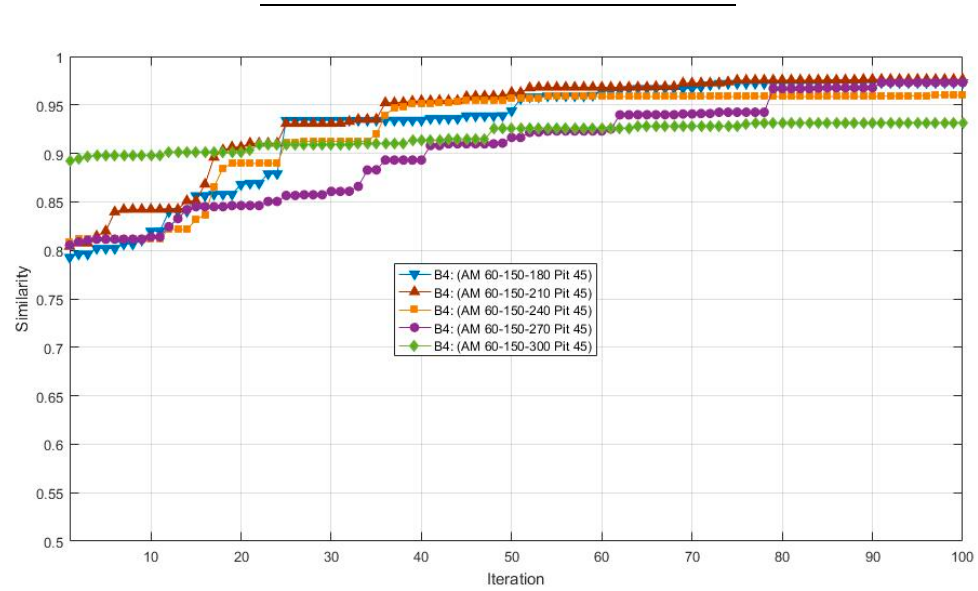
Figure 7. The results of cases (60-150-X, 45) in 100 iterations.